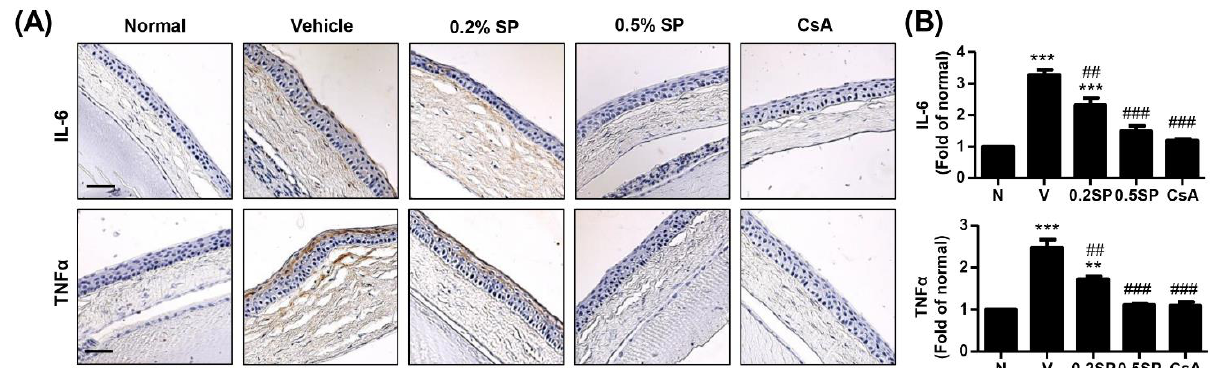
Figure 5. Effect of spermidine on inflammation of the cornea in a rat model of PM 2.5 -induced DED. ( A ) Representative images of immunohistochemical staining for IL-6 and TNF-α corneal sections. Scale bar; 50 μm. ( B ) The stained area of the photograph was quantitative analyzed using ImageJ ® and calculated in terms of the fold of the normal. The data are expressed as the means ± standard deviation (n = 3). ** p < 0.01 and *** p < 0.001 compared to normal group. ## p < 0.01 and ### p < 0.001 compared to the vehicle